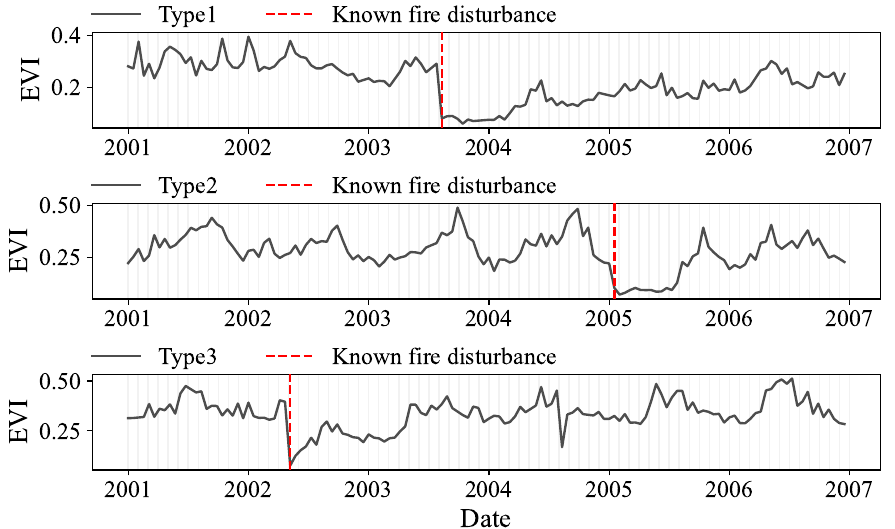
Figure 2. Three types of time series changes caused by forest fire. Type1: EVI time series did not recover in the short term after fire disturbance. Type2: EVI time series recovers within one year after fire disturbance. Type3: EVI time series transient